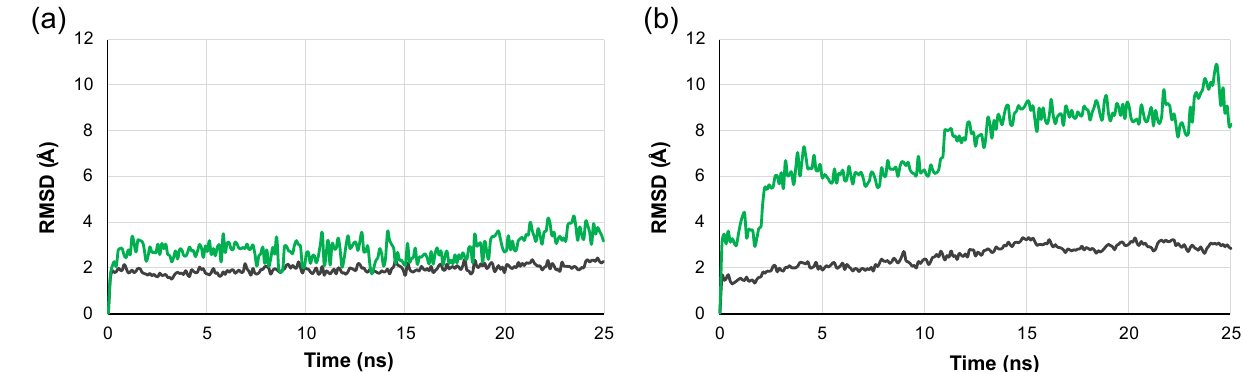
Figure 5. MD simulations for the complexes of pyronaridine with ( a ) RBD and ( b ) ACE2 obtained from docking experiments. Root mean square deviation (RMSD) is depicted in green for the ligand and in dark grey for the protein.